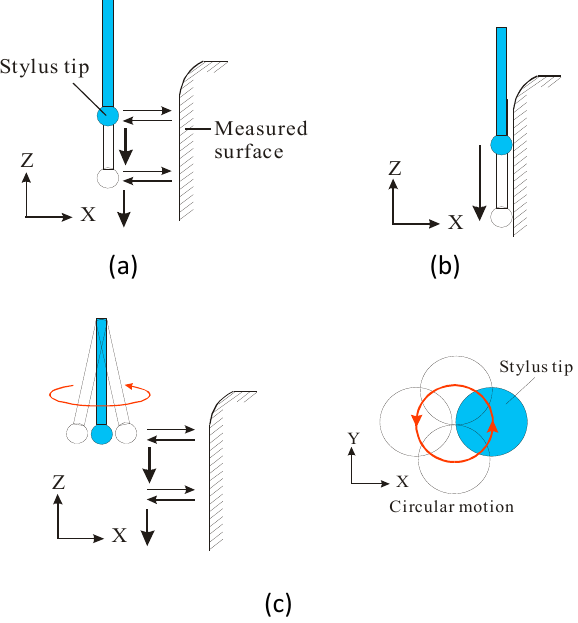
Figure 1. Various types of probes. ( a ) Touch-trigger probe; ( b ) scanning probe; and ( c ) vibrating probe (touch-trigger mode).